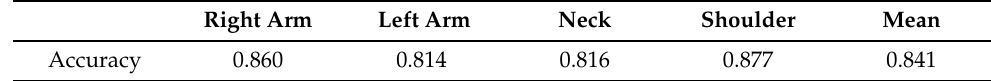
Table 4. Accuracy results for each parameter.